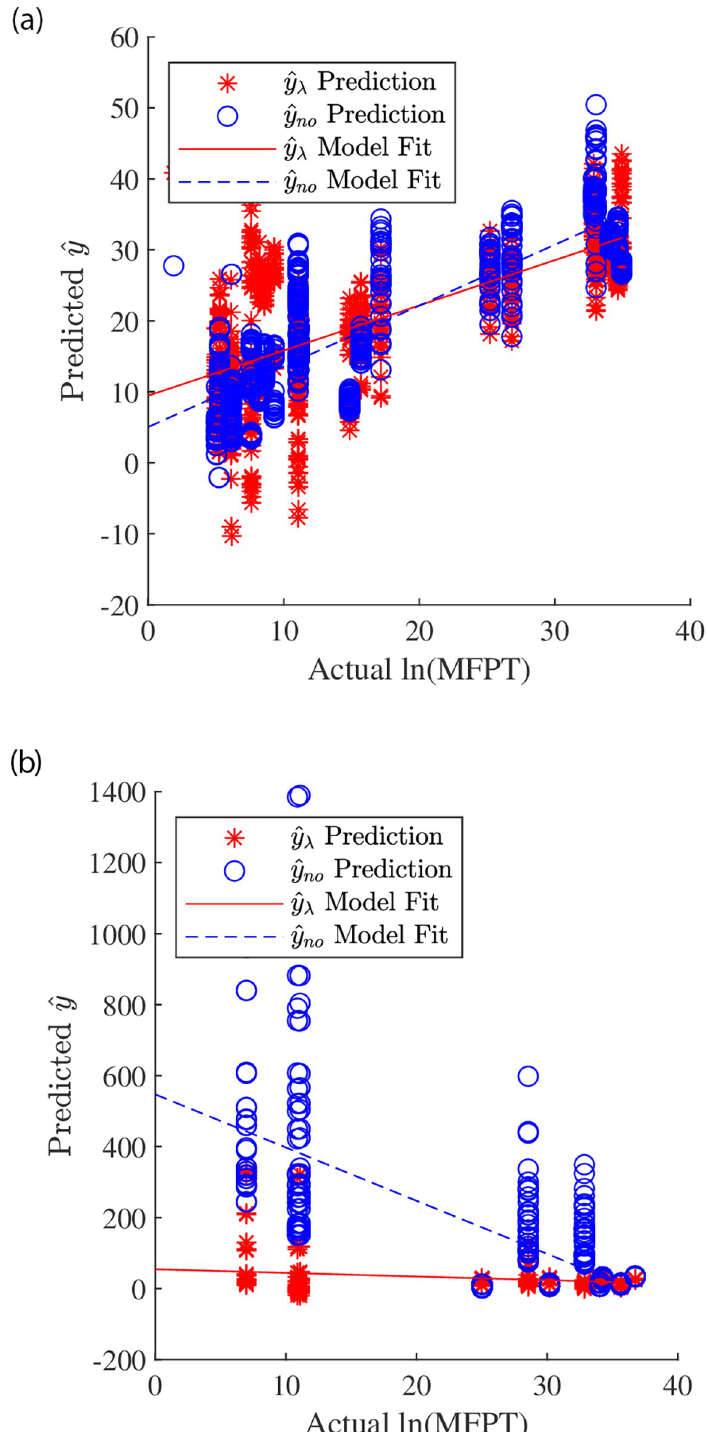
Fig 4. Fall risk model prediction ( ^ y ) compared to the actual MFPT for simulations with 300 steps. (a) shows results for the training gaits that were used to create the model, and (b) shows results for the validation gaits that the model had never seen. Red stars indicate the prediction using the fall risk model that includes the long-term Lyapunov exponents ( ^ y ) and blue circles indicate the prediction using the fall risk model that excludes the long-term Lyapunov l exponents ( ^ y ). In general, as the actual MFPT increased, the prediction from both models increased for both sets of no data. However, the validation gaits had substantially more outliers. https://doi.org/10.1371/journal.pone.0283466.g004 PLOS ONE | https://doi.org/10.1371/journal.pone.0283466 March 27,